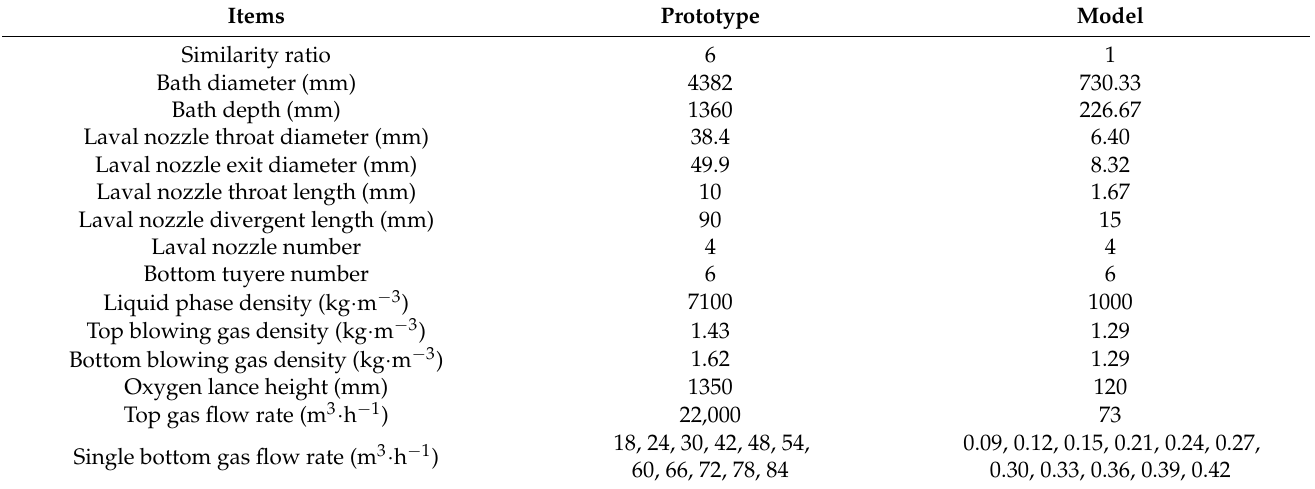
Table 1. Geometrical and operational conditions of the prototype and model.